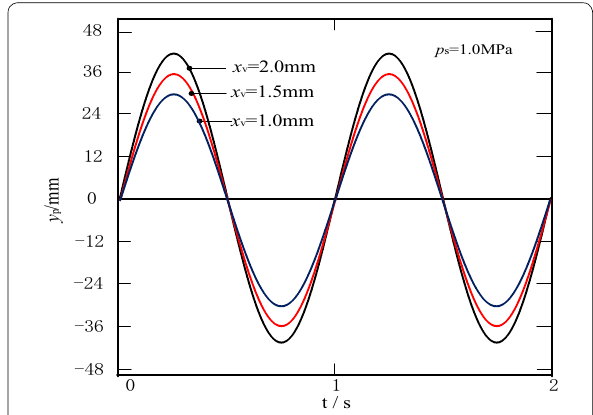
Figure 6 y p theoretical curve under different x v